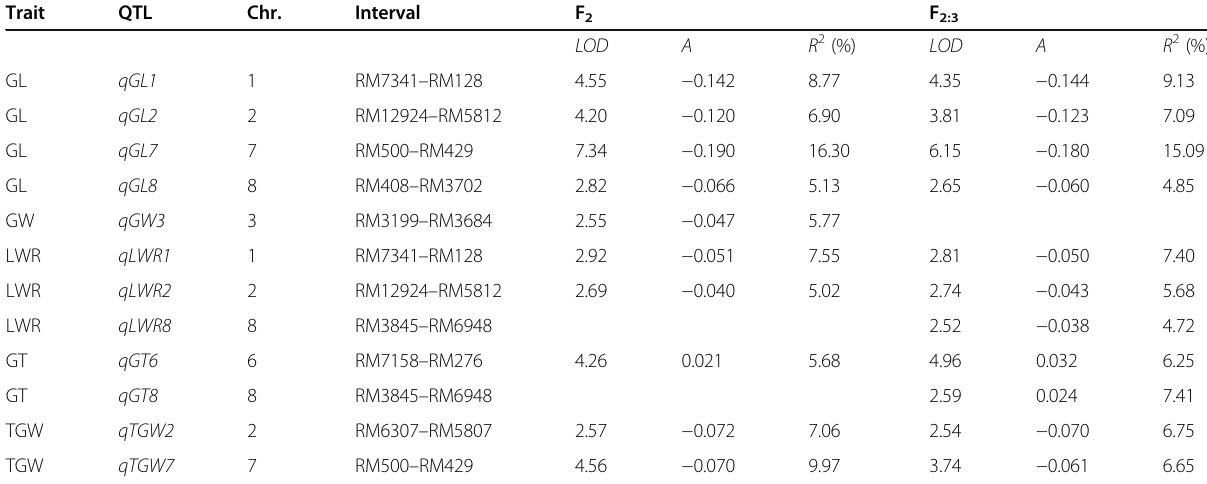
Table 3 QTLs detected for five grain size traits in F 2 and F 2:3 populations Trait